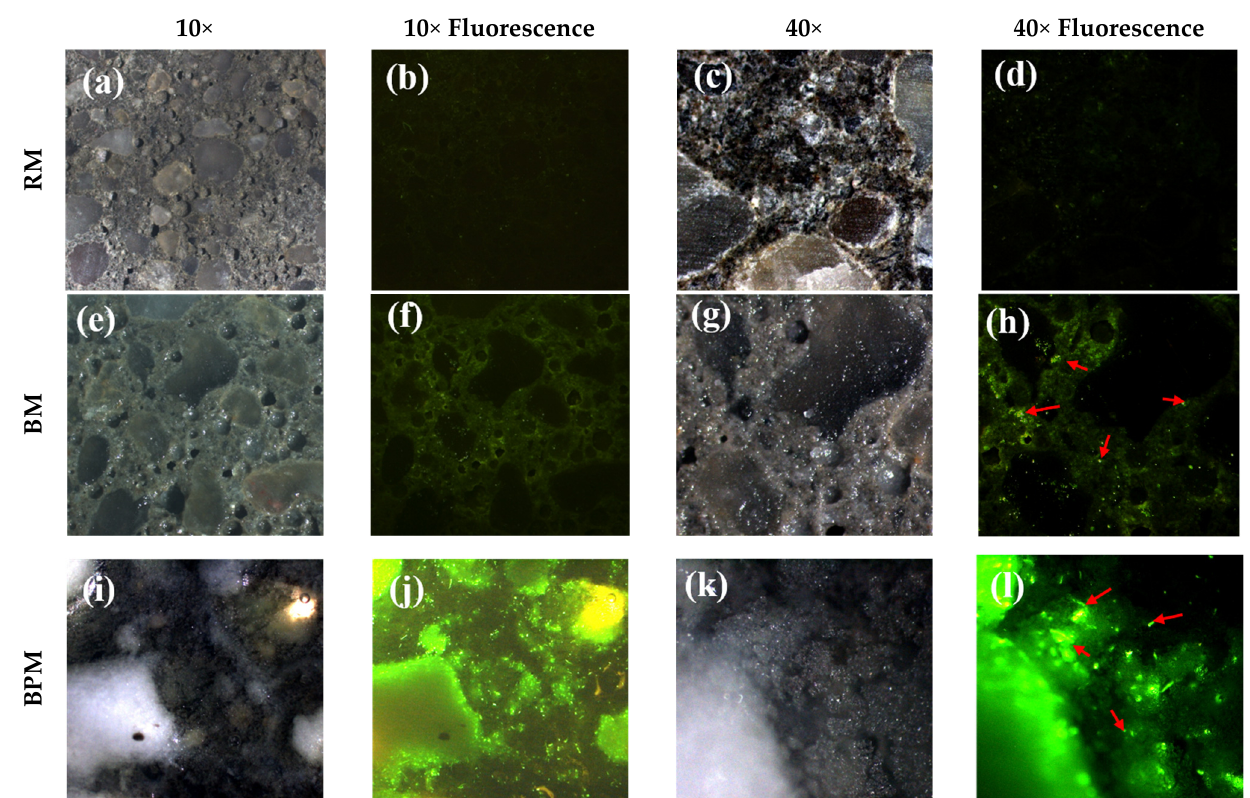
Figure 6. Observation of fluorescence-dyed bacteria distribution over RM ( a – d ), BM ( e – h ), and BPM ( i – l ). Halogen lamp and fluorescence photographing were performed in an environment of 10× and 40× magnification, and the exposure time was set equal to 0.1 s. Red arrows indicate the bacteria colony.